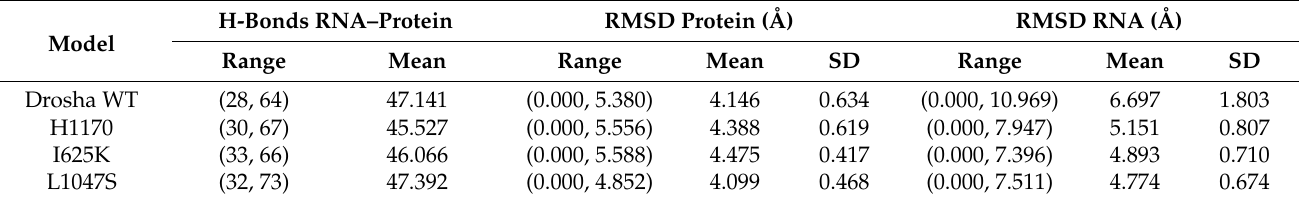
(Table 4). Nevertheless, the calculated binding energy ( ∆ G) between protein and miRNA Table 4. Statistics of energy values of DROSHA complex with RNA. Minimal total energy and mean differs and varies from each introduced mutation: H1170D binds RNA weakly, while I625K total energy values are presented. Binding energy ( Δ G Bind) between protein and RNA was calcu- and L1047S provide stronger interactions with miRNA, and L1047S is characterized by lated by the MM-GBSA method. the most significant increase of binding capacity (Table 4). The obtained MD results are in compliance with the predictions of the mCMS-NA server (Table 1). Table 3. Statistics of MD simulations of DROSHA complex with RNA. H-bonds between protein and RNA and RMSD values are presented.